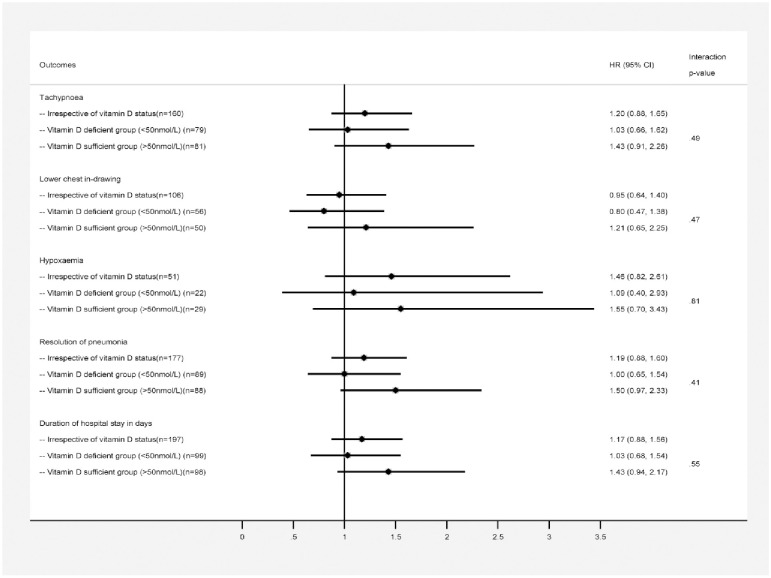
Age adjusted hazard ratios and outcome duration in hour by treatment groups.Foot Note: p-values are >0.05 and indicates that there is no significant interaction observed between vitamin D status (deficient/sufficient) in children and vitamin D treatment groups for each endpoint.